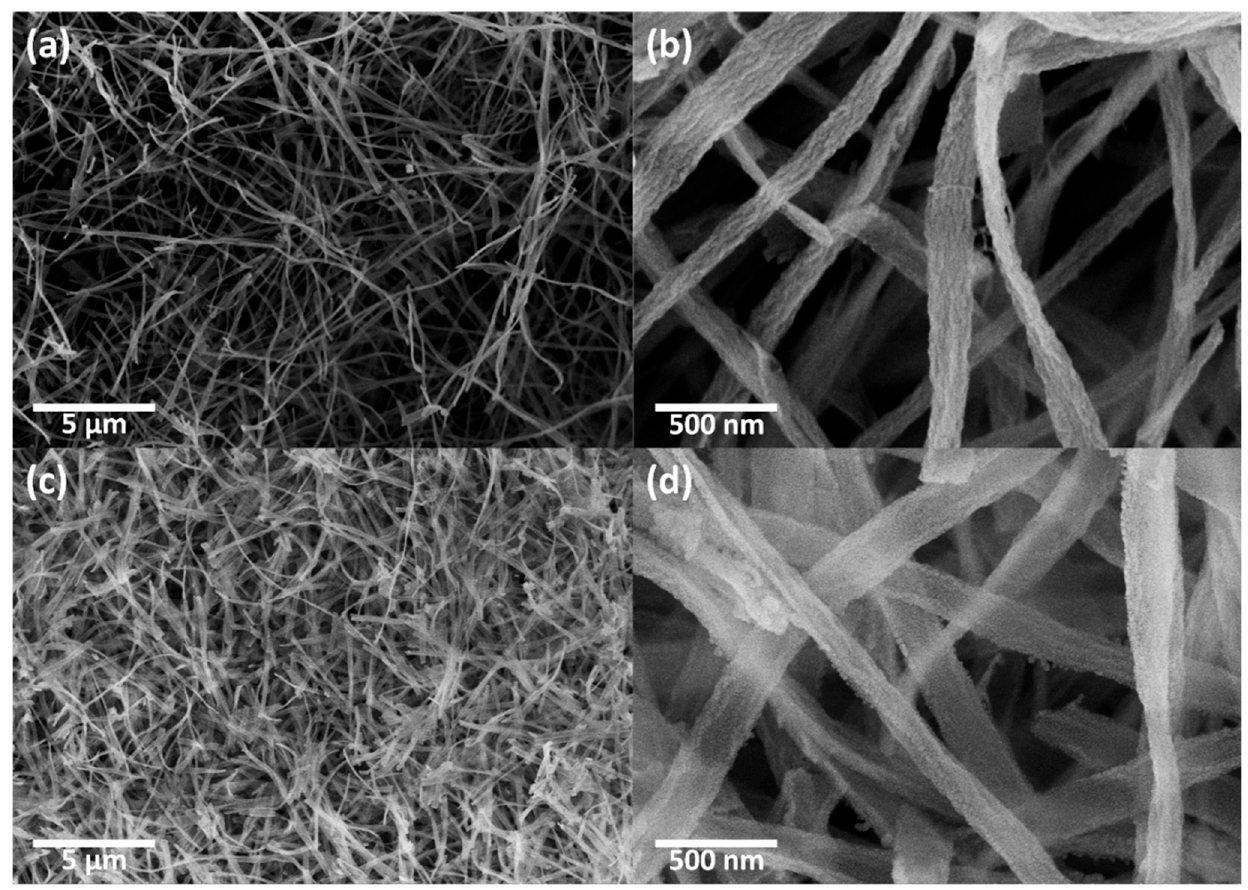
Figure 4. FESEM image of ( a , b ) CeO 2 nanofibers and ( c ,d) CeO 2 -CuCrO 2 nanofibers. Figure 4. FE SEM image of ( a , b ) CeO 2 nanofibers and ( c ,d) CeO 2 -CuCrO 2 nanofibers.